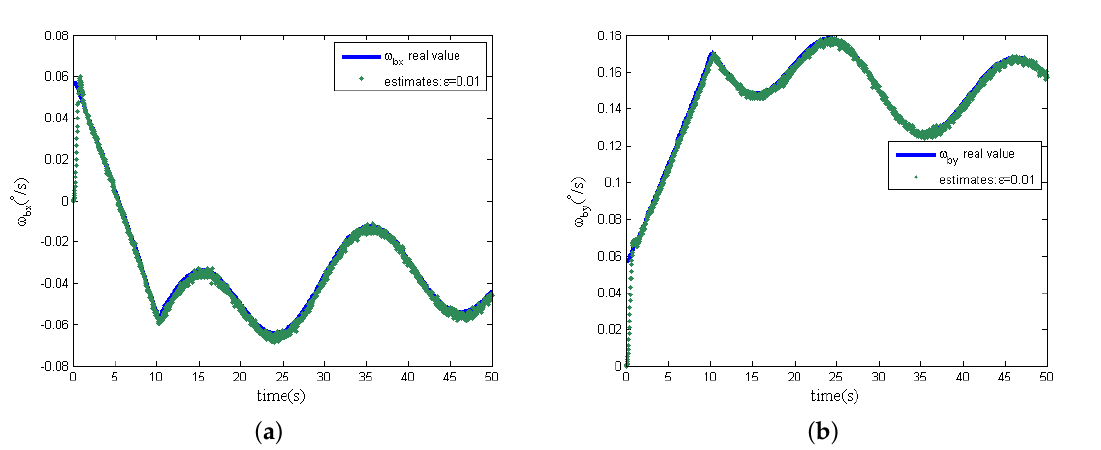
Figure 7. Estimation of spacecraft angular rates with measurement noise ( ε = 0.01). ( a ) x-axis angular rate ω bx ; ( b ) y-axis angular rate ω by .